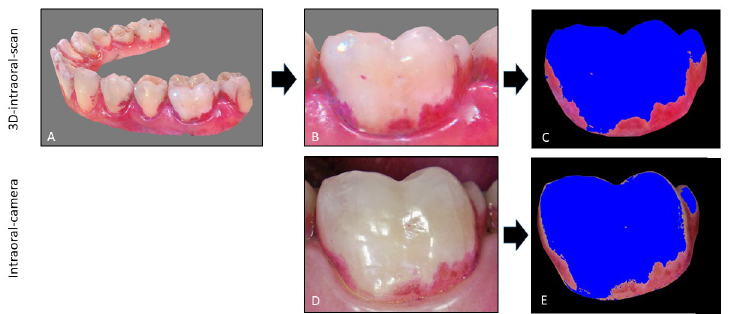
Fig 3. Procedure of planimetric evaluation on a 3D-intraoral-scan and an intraoral-camera image. A, B and C show the procedure for a 3D-intraoral-scan. A: the 3D-intraoral-scan itself, B: image of the tooth of interest from a 3D- intraoral-scan, C: Visualisation of the plaque amount by converting all pixels below a certain threshold value for red by the programme on a cropped tooth on a black background. D and E shows the procedure for an intraoral-camera image. D: intraoral-camera image itself, E: Visualisation of the plaque amount by converting all pixels below a certain threshold value for red by the programme on a cropped tooth on a black background.